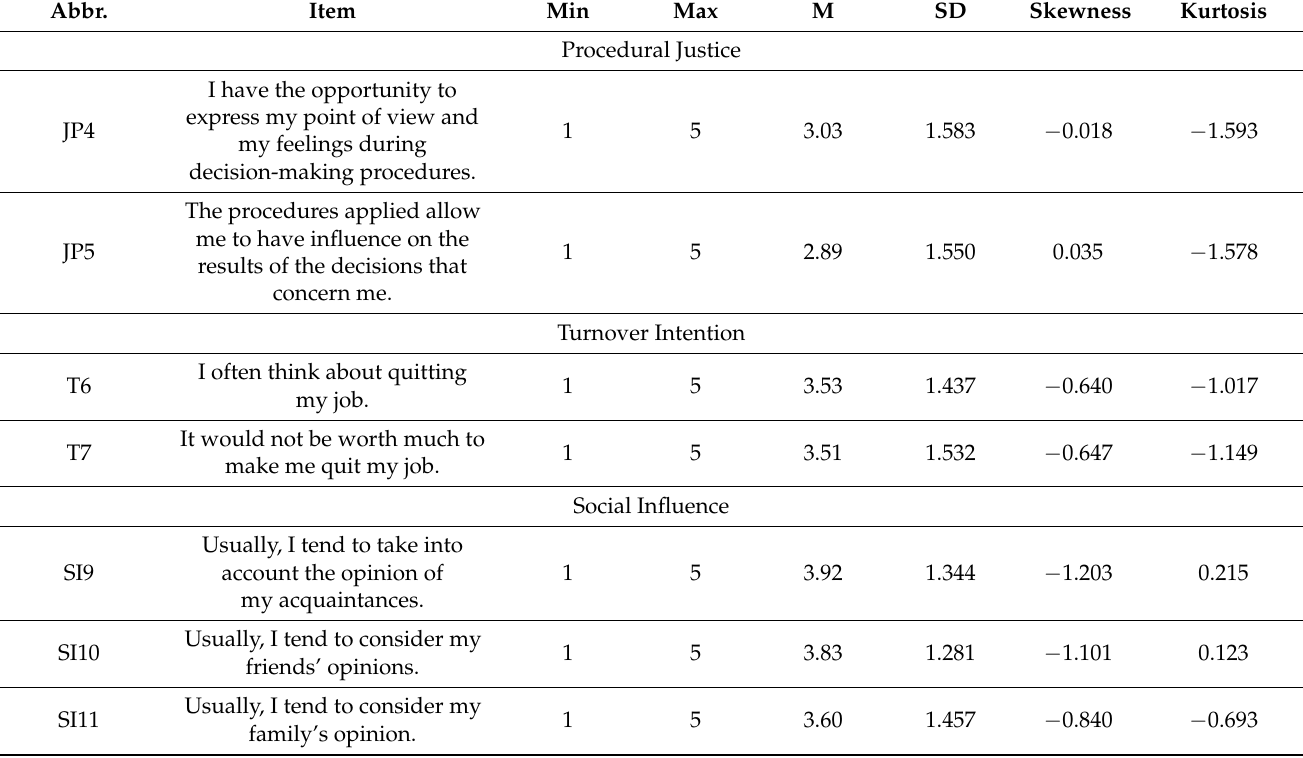
Table 1. Descriptive statistics (developed by authors based on previous